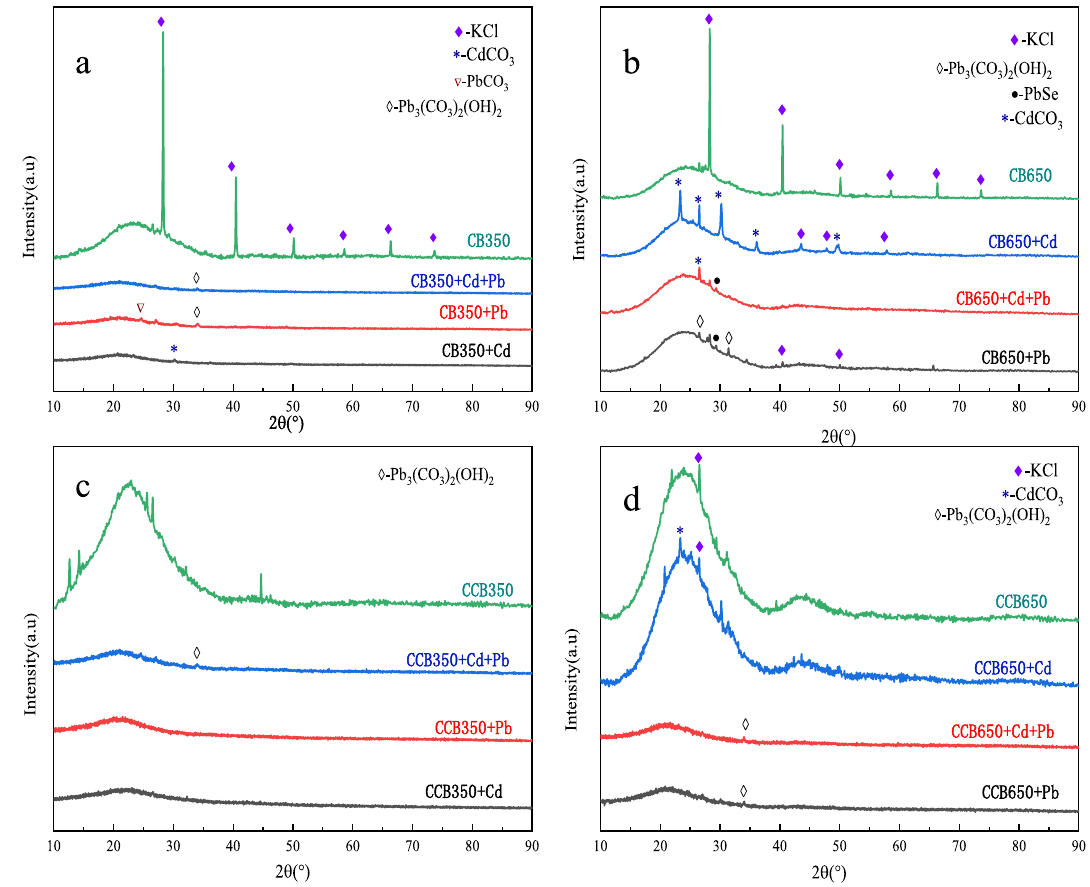
Figure 6. XRD patterns of biochars before and after reaction with Cd 2+ and Pb 2+ in the single and binary systems ( a for CB350, b for CB650, c for CCB350, and d for